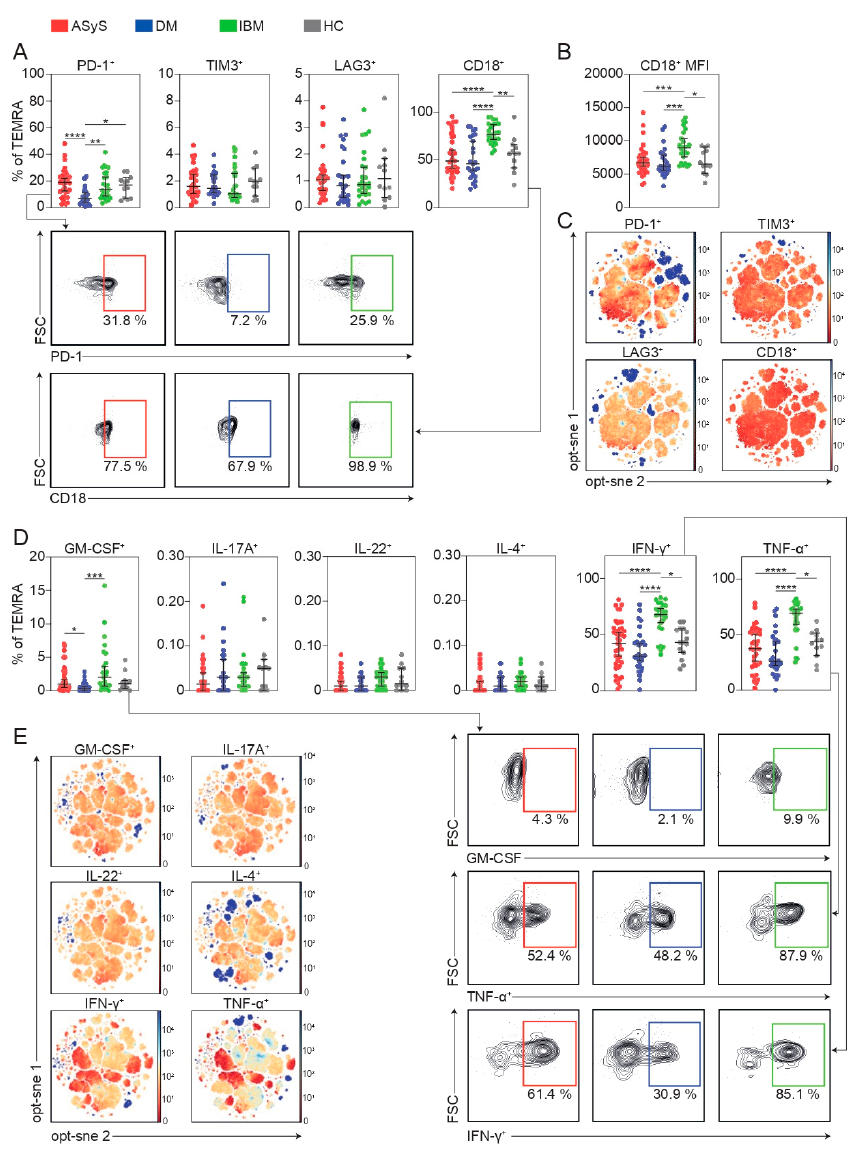
Figure 4. IBM is characterized by distinct changes to the TEMRA population. ( A ) Frequencies of indicated TEMRA cells and representative flow cytometry plots. ( B ) MFI of surface CD18 on TEMRA cells. ( C ) Global optimization of tSNE (opt-sne) projection of the CD8 T cell population for all patients concatenated and overlaid. Expression of indicated proteins is colour coded. ( D ) Frequencies of indicated TEMRA cells and representative flow cytometry plots. Each point represents an individual ASyS (red), DM (blue), IBM (green) patient or healthy controls (grey). ( E ) opt-sne projection of the CD8 T cell population for all patients concatenated and overlaid. Expression of indicated proteins is colour coded. Significance was determined by Kruskal–Wallis test: * p < 0.05, ** p < 0.01, *** p < 0.001, and **** p < 0.0001. Abbreviations: ASyS = anti-synthetase syndrome; DM = dermatomyositis; IBM = inclusion body myositis; MFI = mean fluorescence intensity; TEMRA = terminally differentiated effector memory T cells; tSNE = t-distributed stochastic neighbour